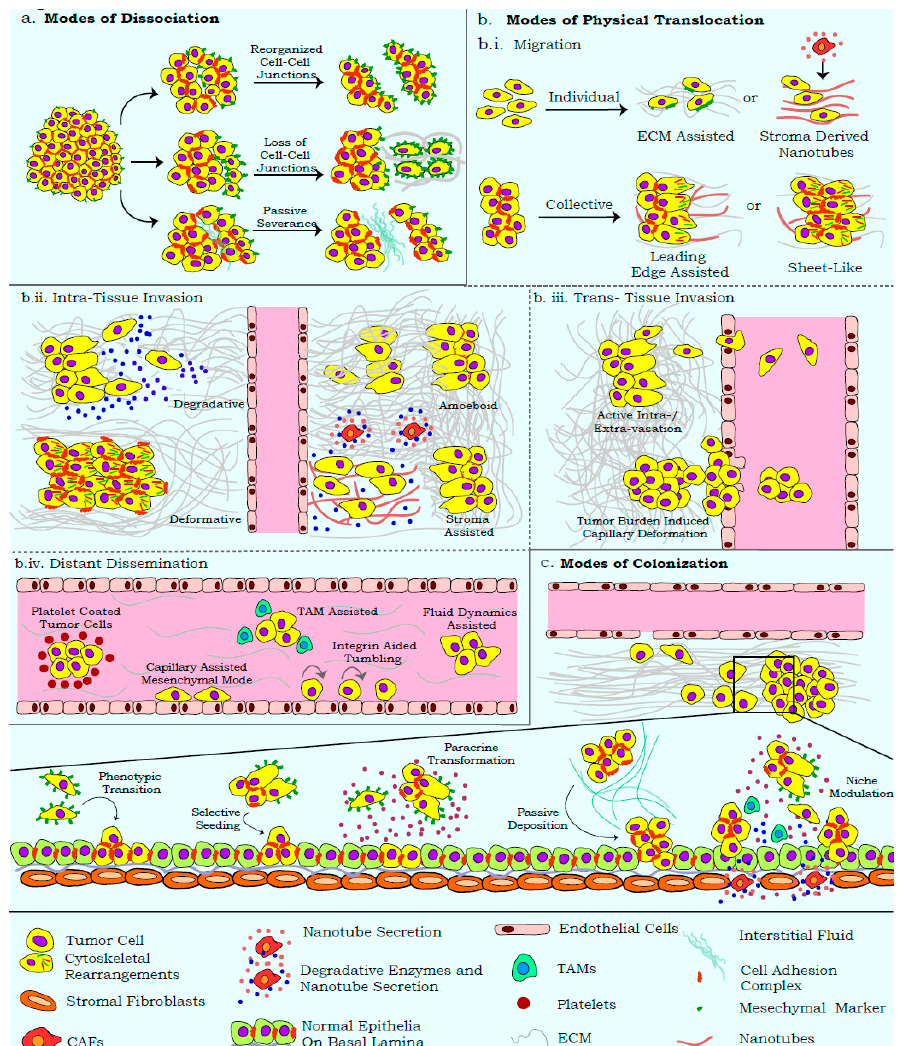
Figure 2. Modalities of metastasis. Metastasis is achieved by a step wise progression of tumor cell dissociation, physical translocation, and colonization. ( a. ) Cell dissociation entails a combination of cell–cell junctional complex rearrangements; phenotypic transitions, like EMT, that result in a loss of epithelial junctions; or the passive severance of cell clusters by virtue of forces exerted by the interstitial fluids. ( b.i. ) Physical translocation involves a myriad of processes, amongst which cell migration is mediated by individual or collective clusters of cells. Individual cells migrate with the aid of ECM or stroma derived nanotubes, whereas collective migration is achieved by an active leading edge and/or by migration of cell sheets. ( b.ii. ) Migrating cells then undergo intra- and trans-tissue invasion by mediating distinct interactions with the ECM and non-transformed cell populations. Intra-tissue invasion involves the degradation and deformation of the ECM, either by the tumor or stromal cells. Alternatively, cells exhibit amoeboid invasion by altering their membrane fluidity so as to squeeze through the ECM with minimal disturbance to the surrounding architecture.